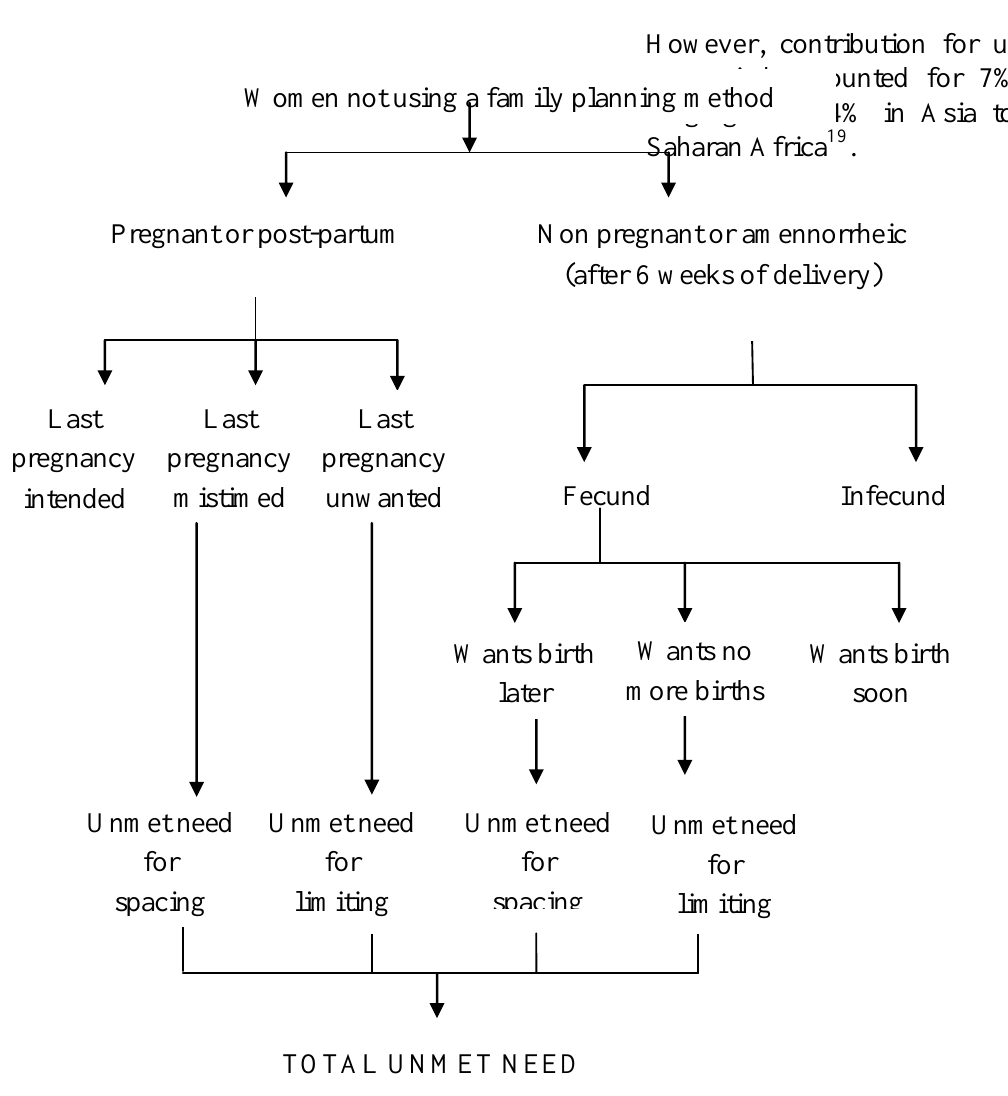
Figure 1 - Arrangement of currently married women of reproductive age in various categories of pregnancy, fecundity and fertility intention, and total unmet need for FP